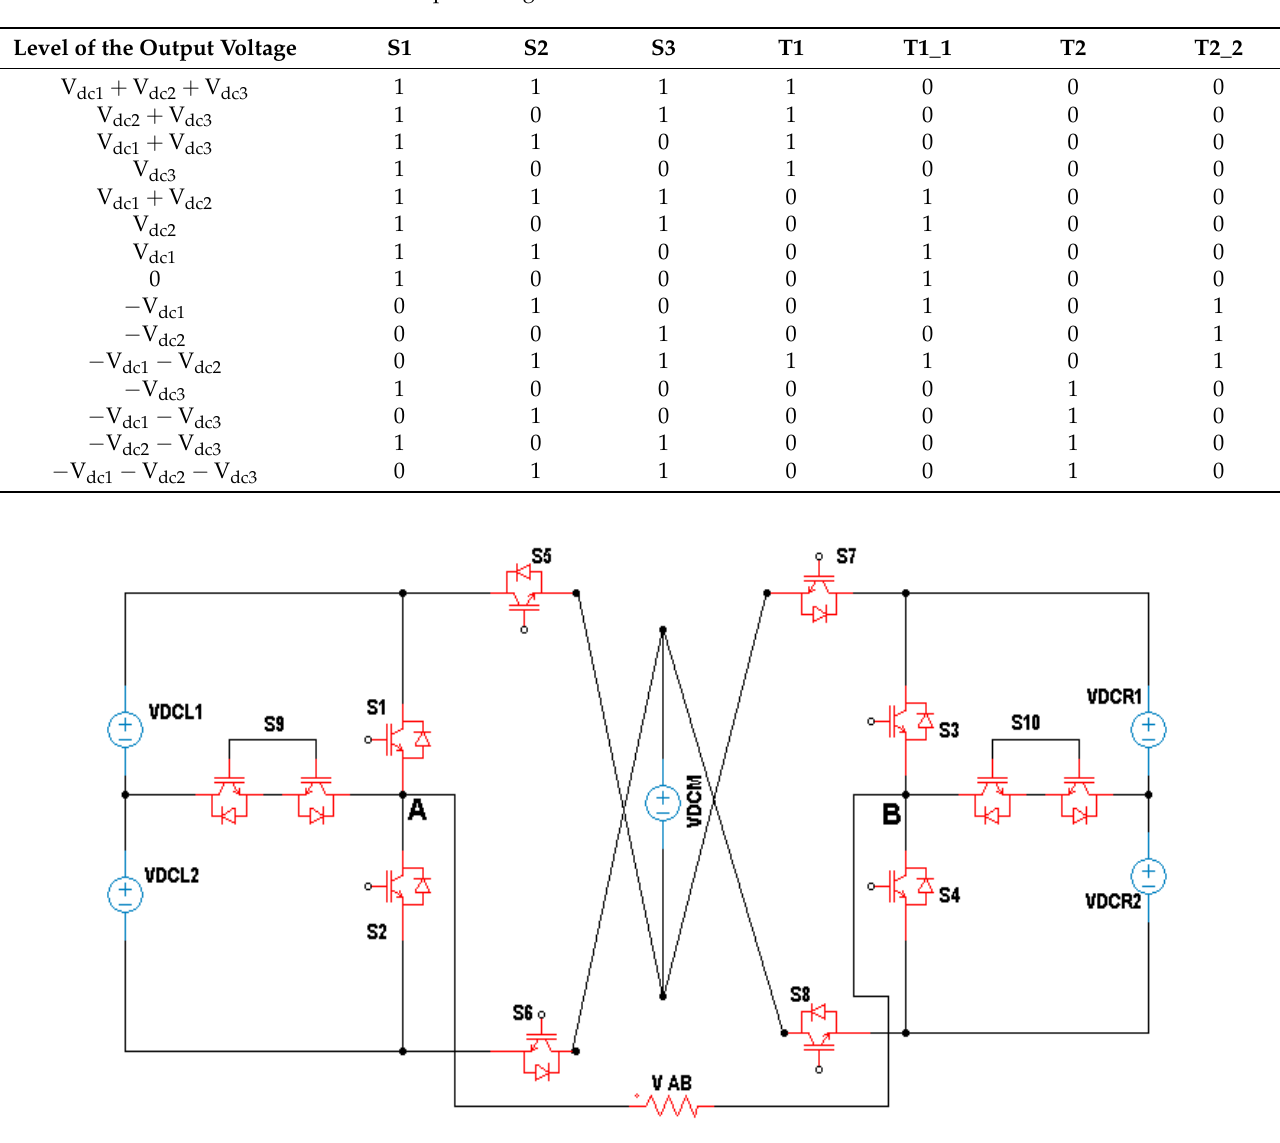
Figure 12. A single-phase 11-level HT-type multilevel inverter.